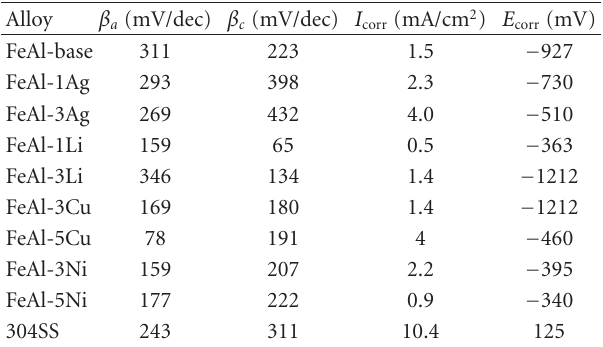
Table 1: Electrochemical parameters obtained from polarization